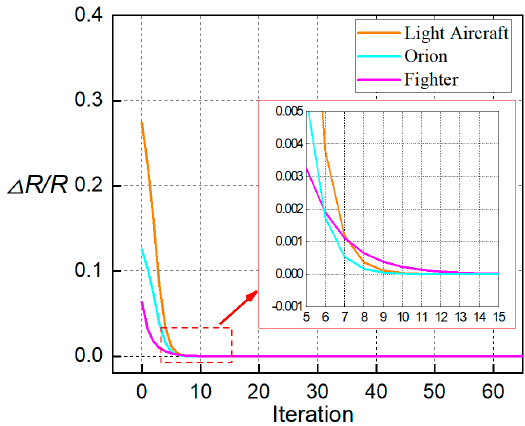
Figure 3. Residuals △ R/R vs. iteration steps.